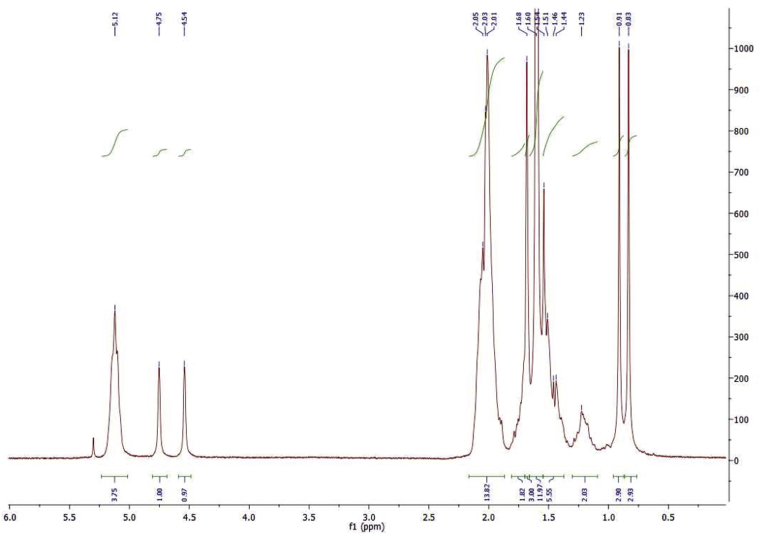
1H NMR spectrum of 3-deoxyachilleol in CDCl3.